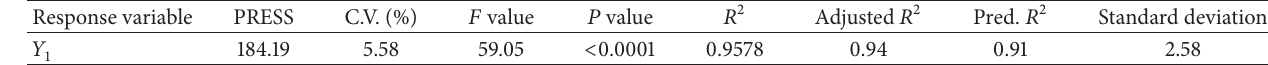
Table 4: Analysis of variance (ANOVA) for the model.